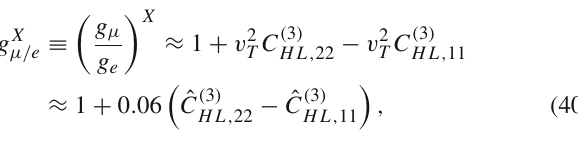
Fig. 3 Current constraints from electroweak observables at 2 σ , in comparison with projected sensitivities of precision Higgsstrahlung measurements. The red-ruled regions indicate | (cid:8)σ/σ | < 0 . 5% at √ s = 240GeV.Thedot-dashedanddottedredlinesarethecorrespond- √ s = 240GeV and 365GeV, respectively. The ing 1% contours at